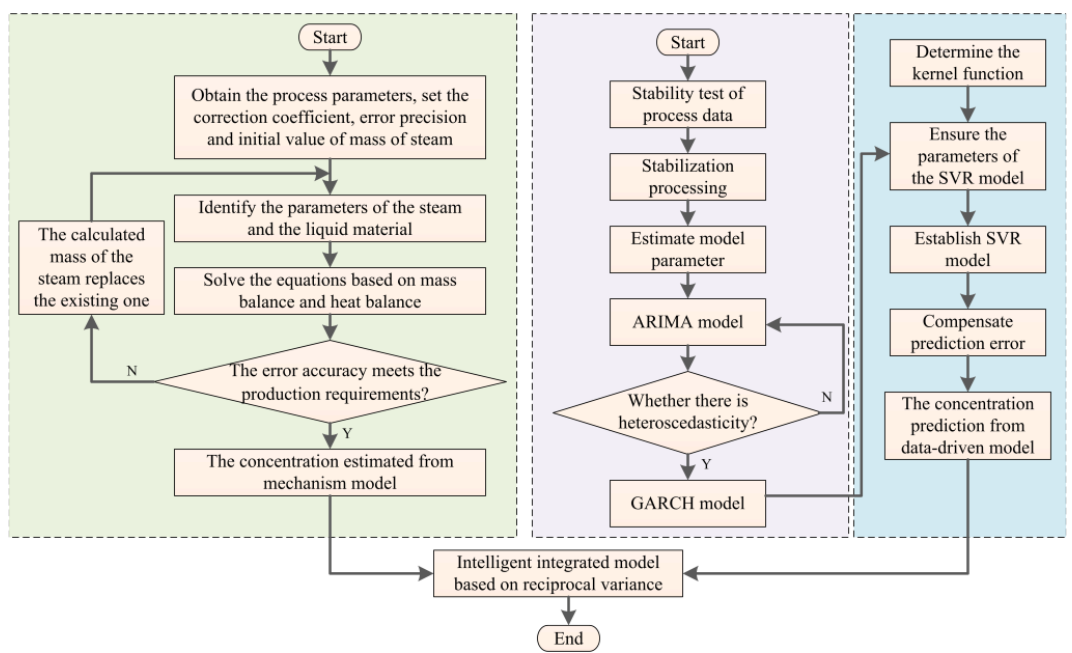
Figure 3. The ARIMA-GARCH-SVR data-driven prediction process.